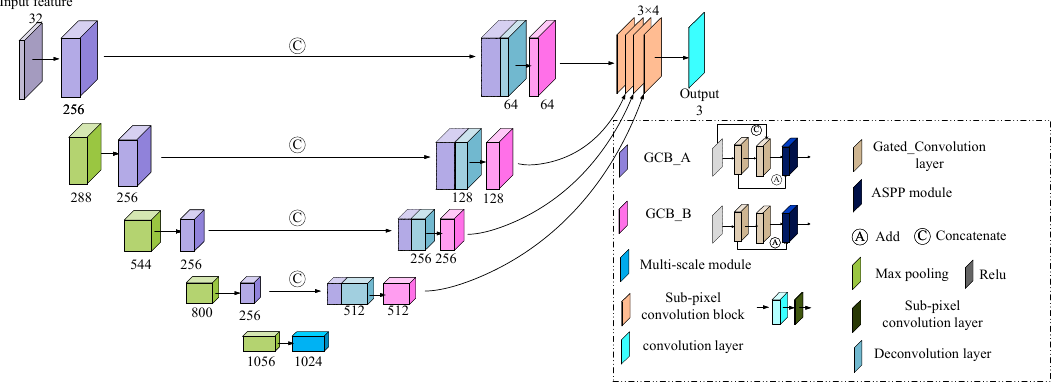
Figure 2. The structure of the network. The traditional convolution layers are replaced by the gated convolution layers with two types GCB_A (purple) and GCB_B (pink). A multi-scale module (sky blue) is applied at the top of the encoder, and a multi-scale fusion is introduced to concatenate the last features of di ff erent scales of decoder, which are upsampled with sub-pixel convolution blocks (orange) respectively.